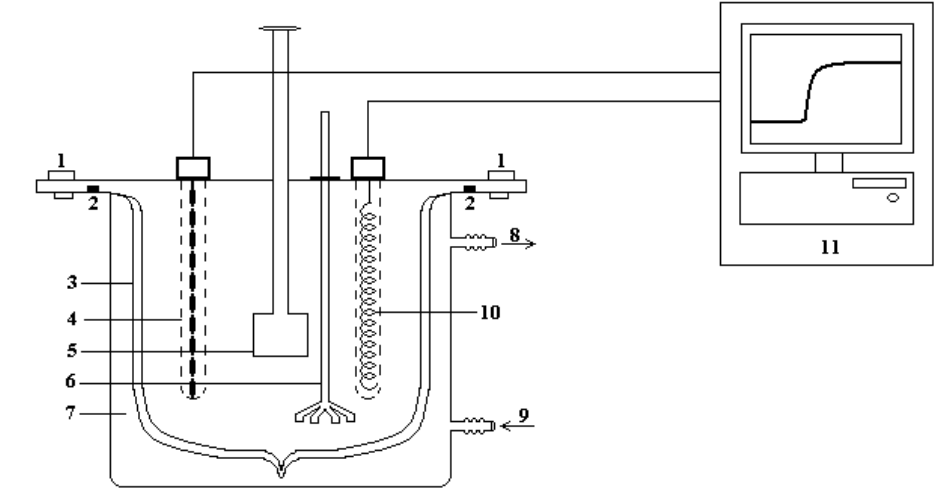
Figure 1 . Isoperibol microcalorimeter. 1. Screws. 2. O-ring. 3. Dewar. 4. Thermistors. 5. Glass ampoule. 6. Agitation system. 7. Thermostat. 8 and 9. Water inlet and oulet. 10. Heater resistance. 11. Capture